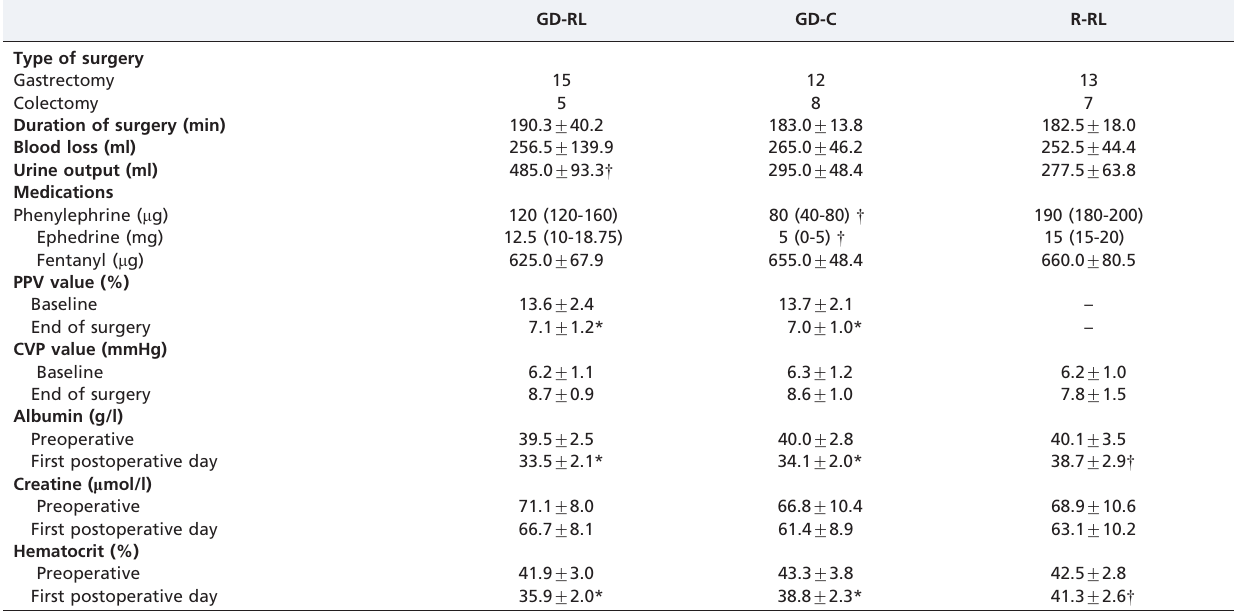
Table 2 - Perioperative data.